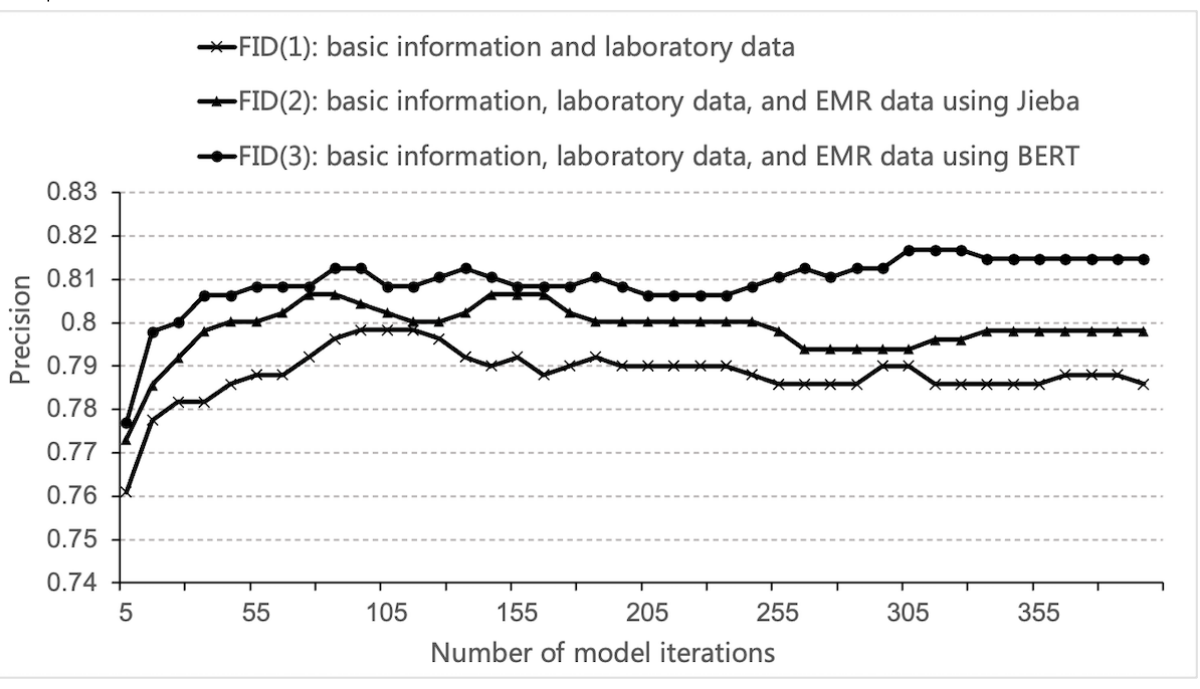
Figure 4. Performance of different data sets. FID: fever of unknown origin intelligent diagnosis. EMR: electronic medical record. BERT: bidirectional encoder representations from transformers.